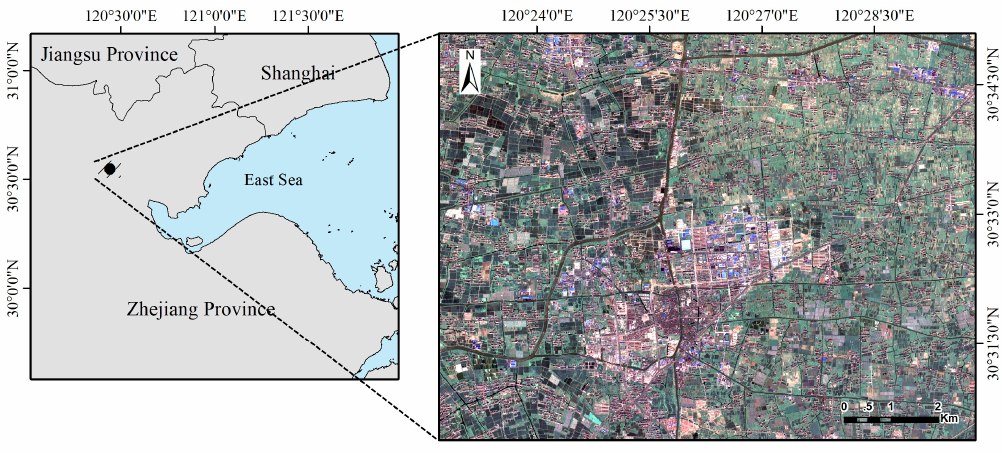
Figure 1. The study area is a typical town–rural region in Zhejiang province. The Gaofen 2 (GF-2) image used in this study is presented in true color.